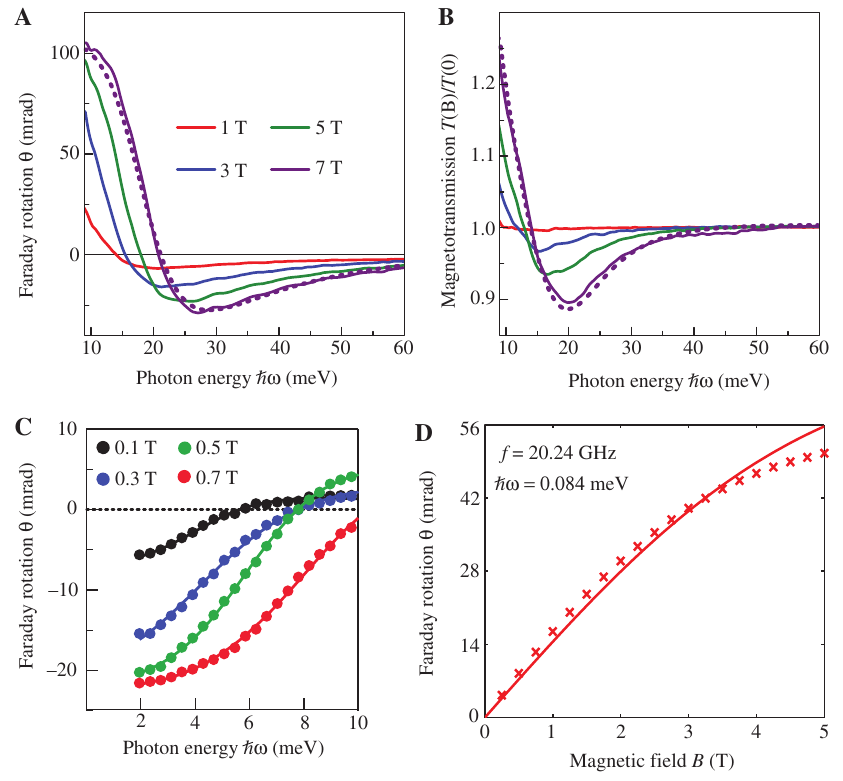
Figure 4: Faraday rotation of single-layer graphene measured at different frequencies and magnetic fields. (A, B) High-frequency and high- magnetic fields (adapted from [81]), (C) lower-frequency and low-magnetic fields (adapted from [82]) and (D) low-frequency and different magnetic fields (adapted from